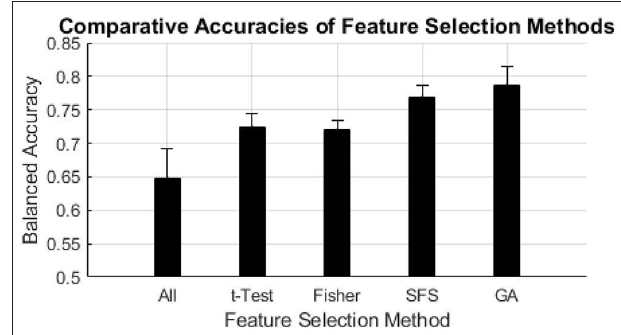
FIGURE 4 | Comparative accuracies of feature selection methods. The black bars indicate the mean balanced accuracy of each feature selection method, the error bars indicate the standard deviation of the balanced accuracy of each feature selection